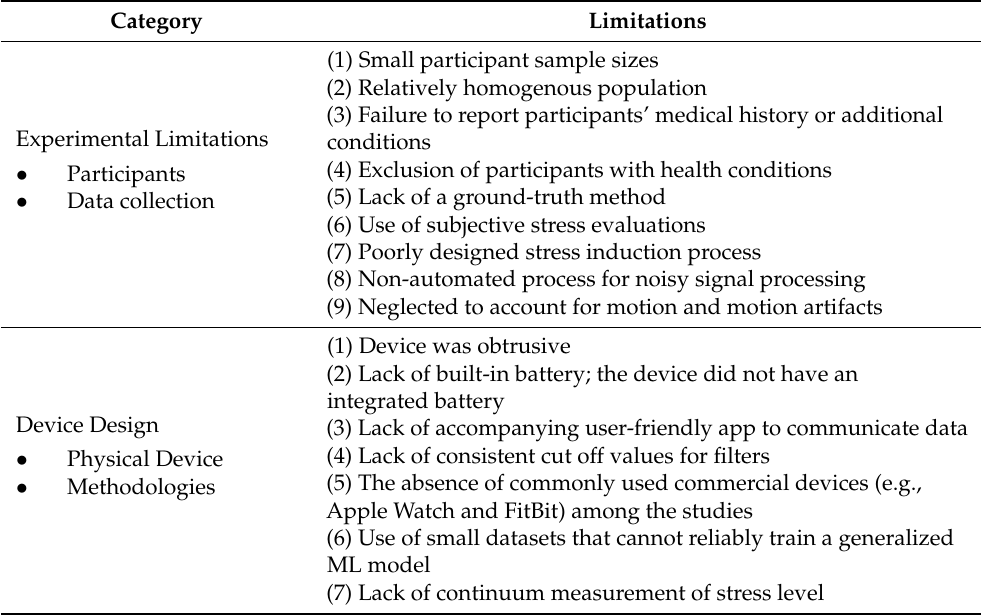
Table 6. Limitations of PPG